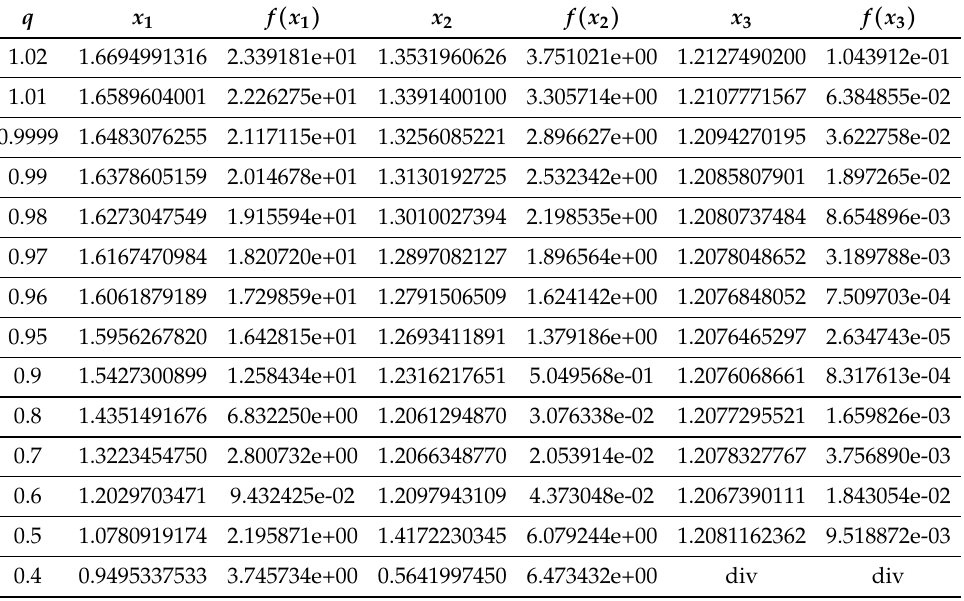
Table 2. Calculation of x i and f ( x i ) for i = 1,2,3 and different values of q by using QAG